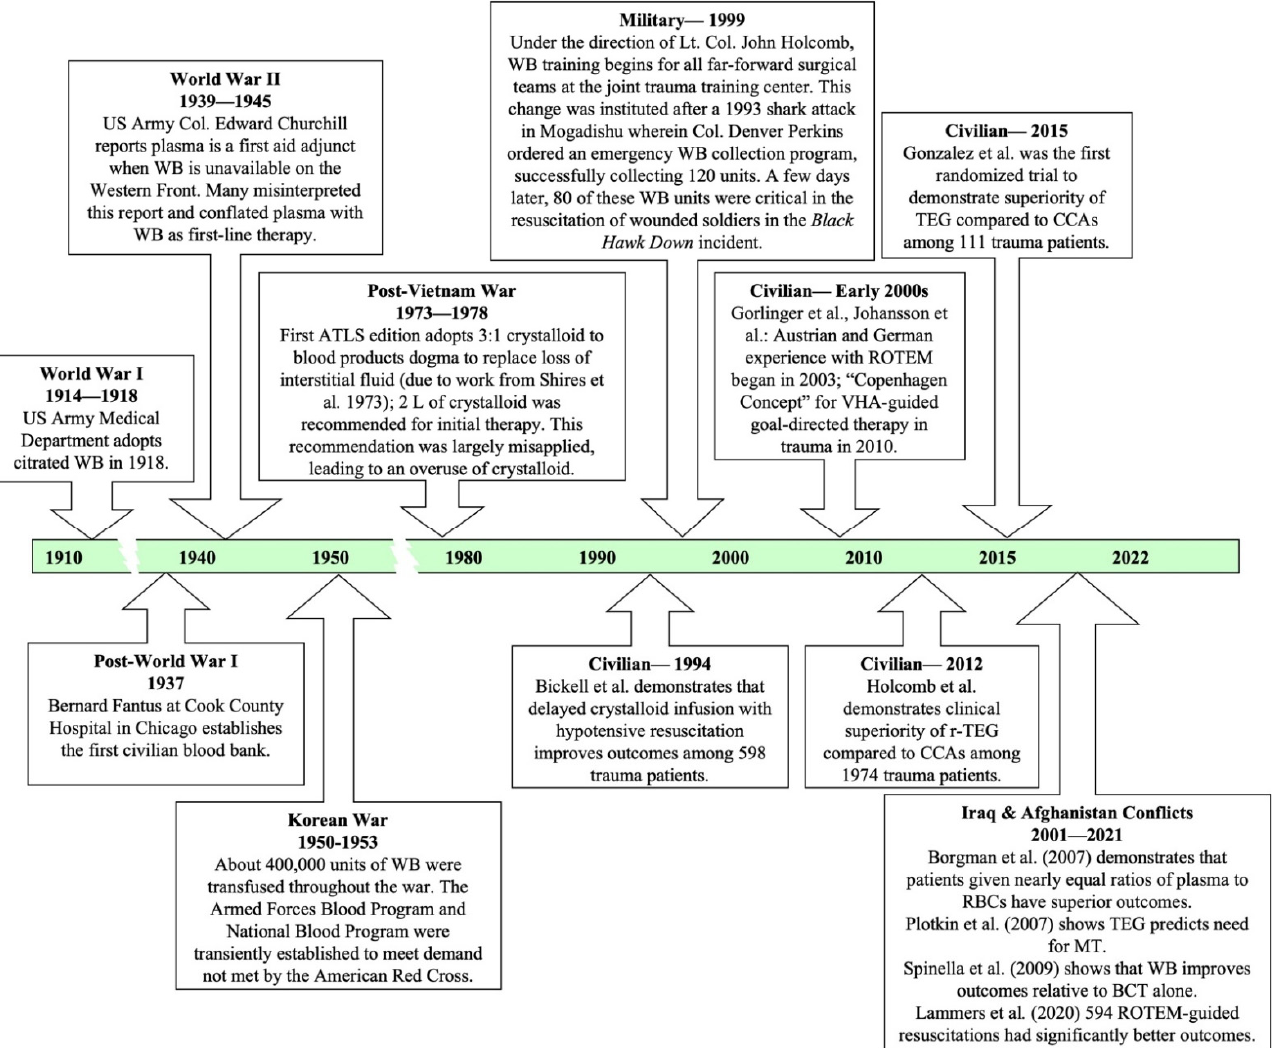
Figure 1. Brief overview of the evolution of trauma resuscitation since the early 1900s in military and civilian settings [4,10,12,15,19–23]. ATLS, Advanced Trauma Life Support; BCT, blood-component therapy; CCAs, conventional coagulation assays; MT, massive transfusion; ROTEM, rotational thromboelastometry; TEG, thromboelastography; r-TEG, rapid thromboelastography .